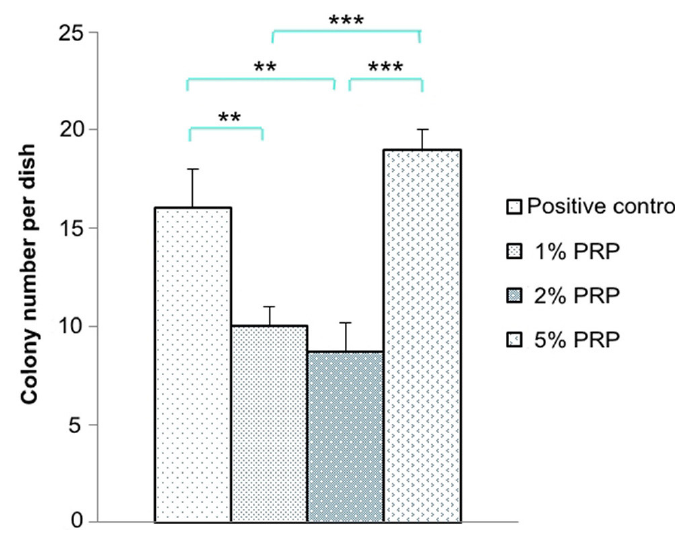
Figure 4- Colony number in experimental media at day 14 (** p<0.01, ***